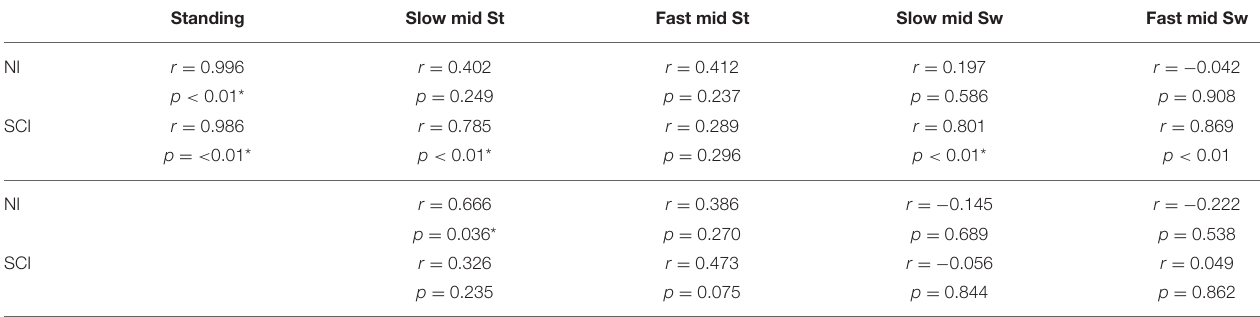
TABLE 3 | Sol H and PRM reflex correlations for the raw (top) and normalized (bottom)